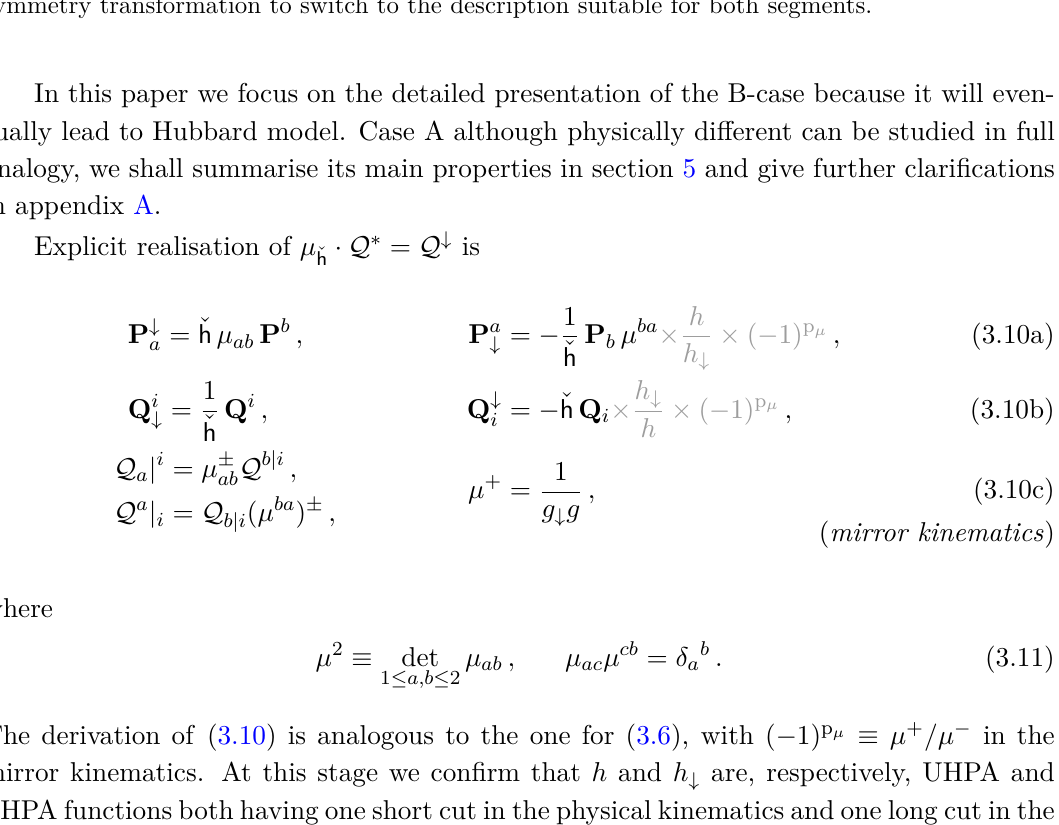
Figure 2 . Analytic continuation perspective on the monodromy bootstrap. Crosses represent the Q-system, there are two of them to emphasise the non-locality of the equations. Q-system can be parameterised using the physical or the mirror kinematics, and an UHPA or a LHPA basis. Along the contour of continuation abcd , only two out of four descriptions are suitable for each of the segments a, b, c, d . For instance, while on a , we should use an UHPA basis but the kinematics is irrelevant; while on b , we should use the physical kinematics and either an UHPA or a LHPA basis are acceptable. Before moving from a segment to the next one, we should use a continuous symmetry transformation to switch to the description suitable for both